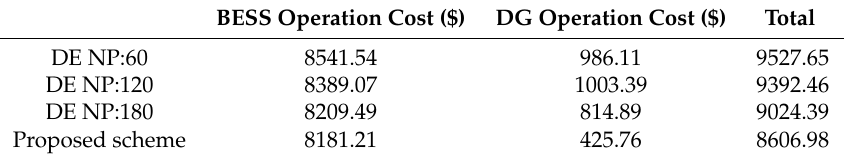
Figure 7. Control inputs for BESS and DG solved with DE algorithm. Table 2. Cost of system units under different